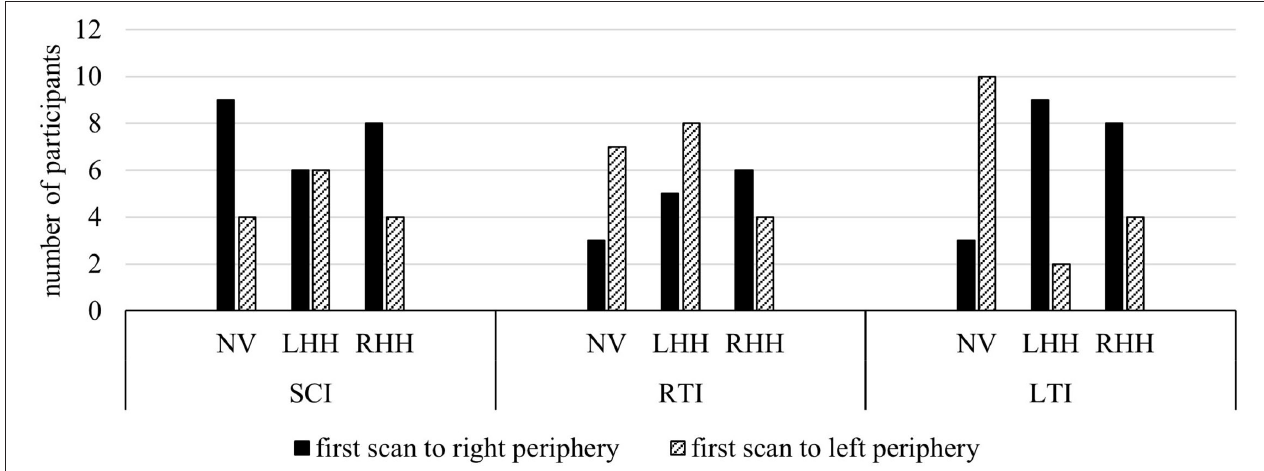
FIGURE 2 | Number of participants making their first scan with a minimum amplitude of 30 degrees toward the left or right periphery. Compared to left-sided first scans, the first peripheral gaze movement was directed to the right hemifield by a similar or greater number of participants during SCI. For turning maneuvers, the participants were more prone to left-sided first scans with NV and right-sided first scans with RHH. LHH produced more right-sided first scans when turning left and more left-sided first scans when turning right.